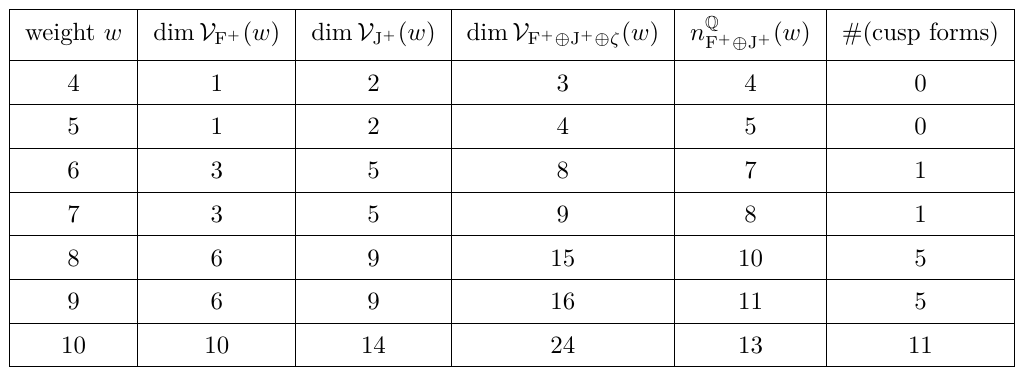
Table 7 . Extracting the minimum number of even cusp forms at weight w by comparing the counting of Laurent monomials in table 6 with the total number of F +( s ) weight w ≥ 7 , an additional even cusp form can be formed by adding multiples of ζ combinations of modular invariants at depth